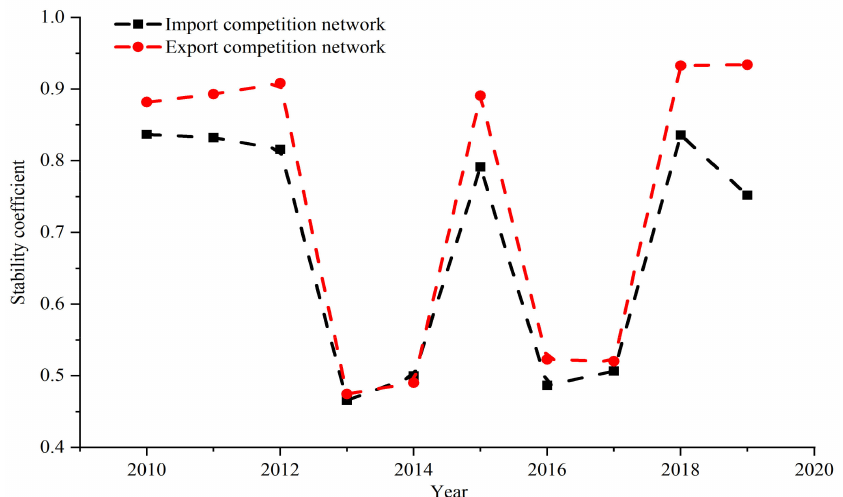
Figure 6. Stability coefficient of import competition network and export competition network.